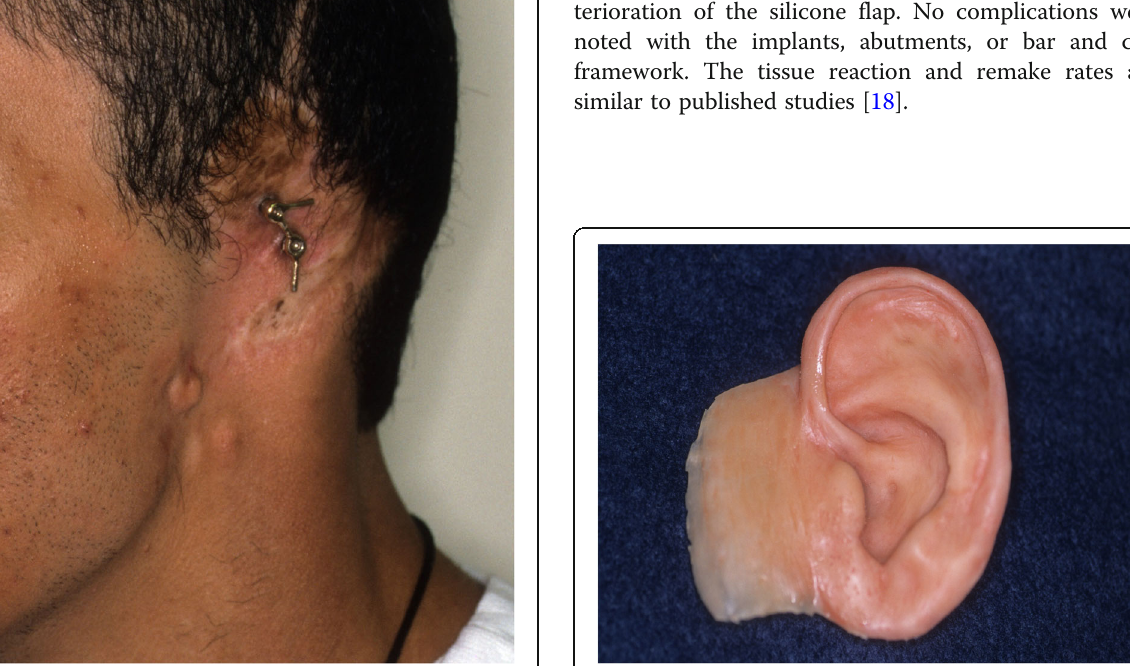
Fig. 10 Processed intrinsically colored prosthesis with tissue